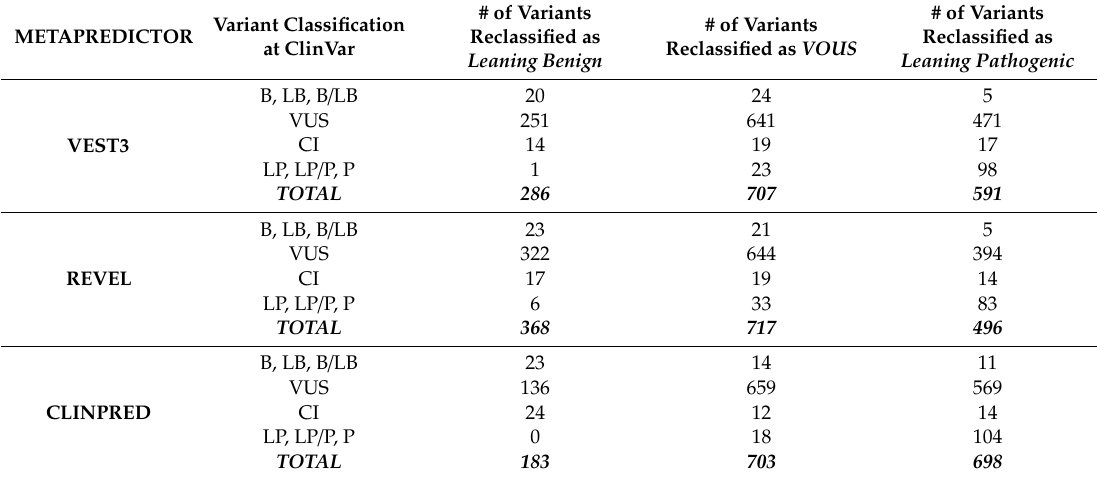
Table 4. Classification categories of variants before and after training predictors. # = number. # of Variants Variant Classification Reclassified METAPREDICTOR at ClinVar